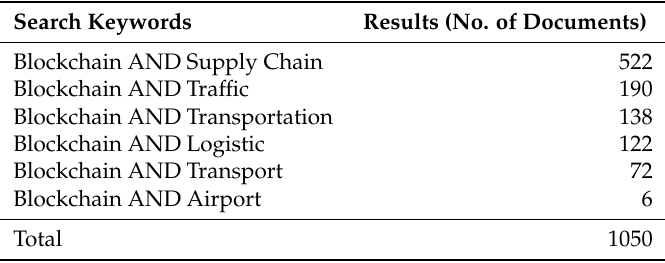
Table 1. First search